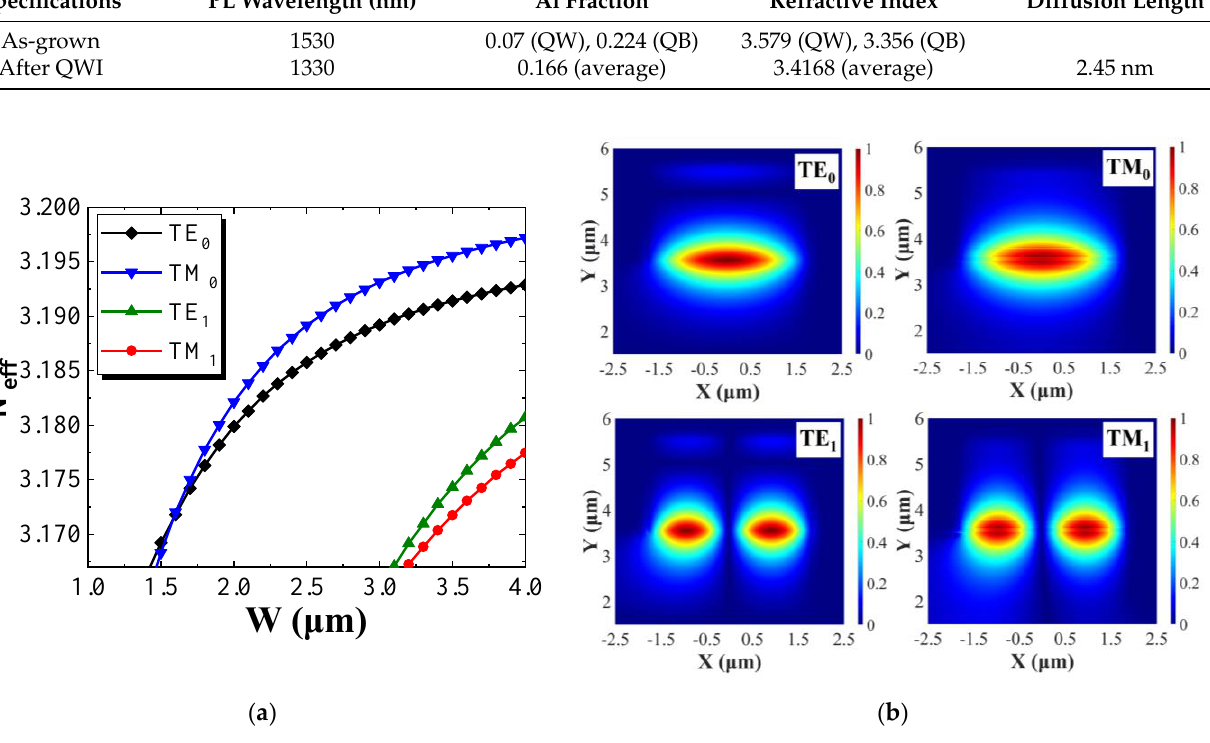
Table 1. Key parameters of the as-grown MQW structure and after bandgap widening by 200 nm using QWI.